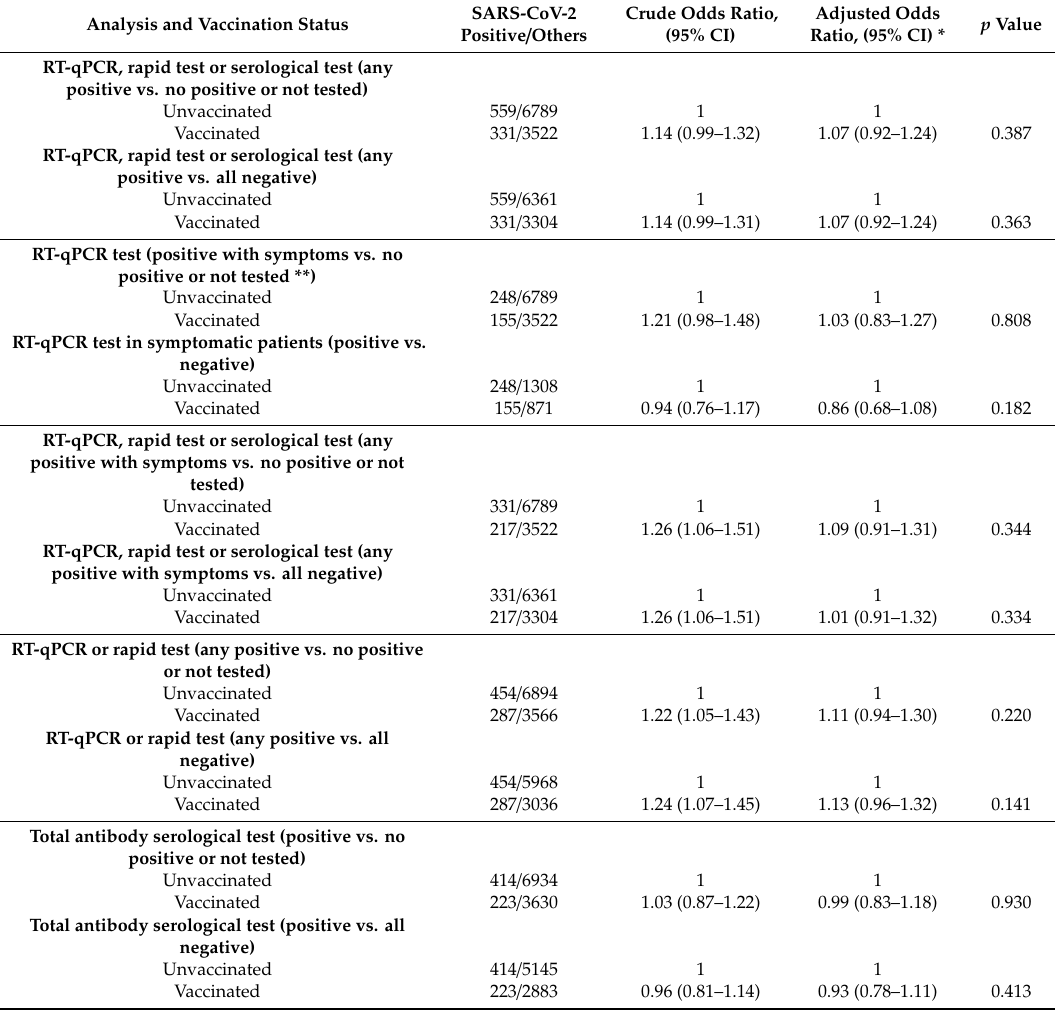
Table 2. Association between influenza vaccination in the 2019–2020 season and SARS-CoV-2 infection by type of diagnostic